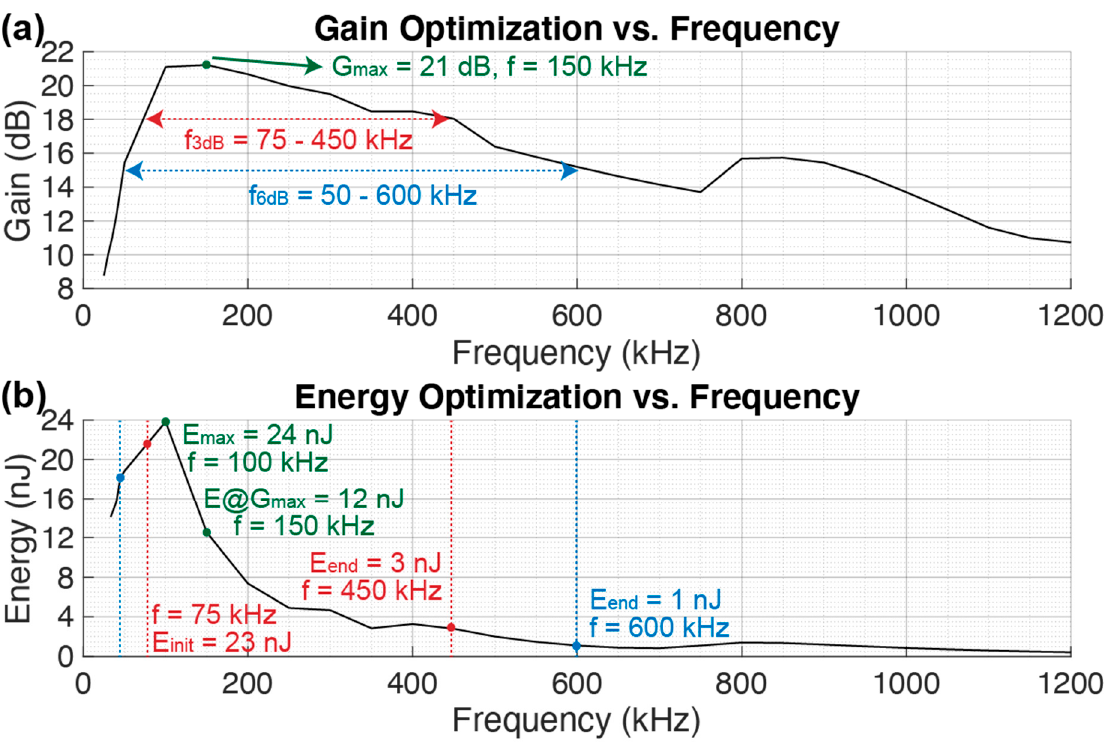
Figure 6. Gain ( a ) and energy ( b ) optimization over a sweep on the modulation frequency f m . The remaining values are maintained constant as in Table